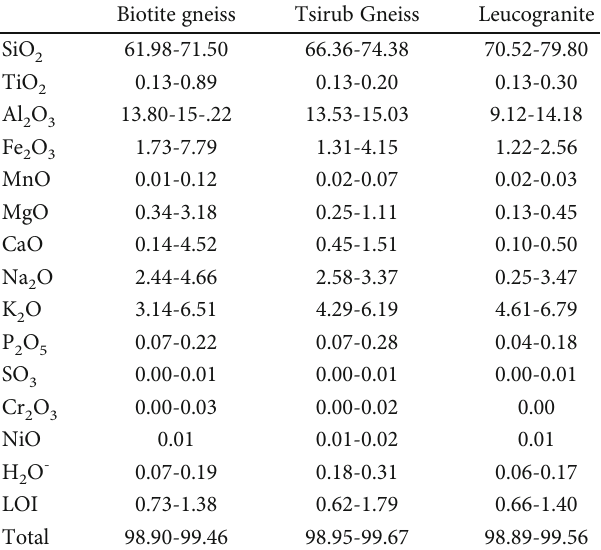
Table 1: Compositional ranges for the biotite gneiss, Tsirub Gneiss, and the